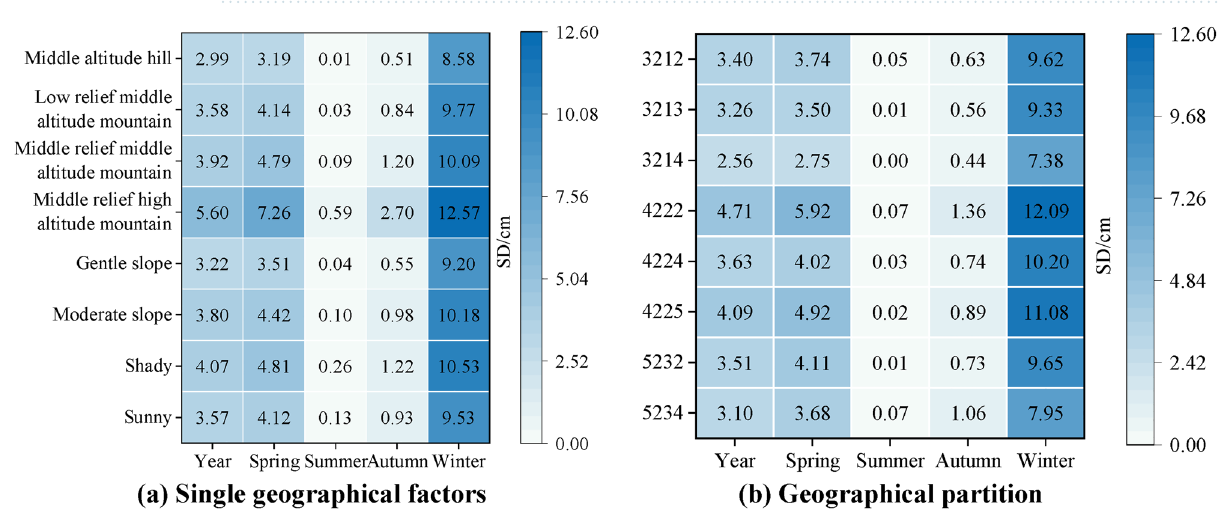
Figure 11. Geographical factors and percentage distribution of evolution area.